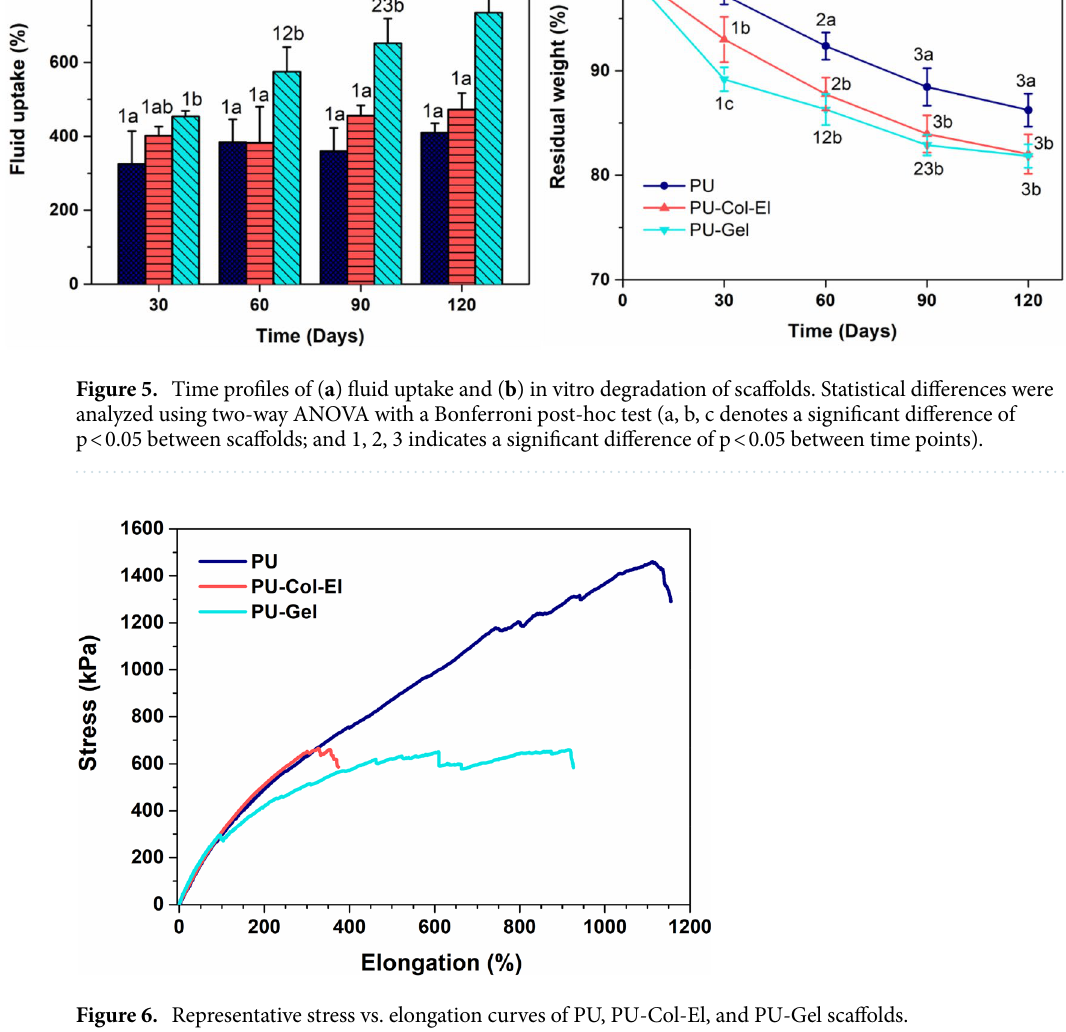
Figure 6. Representative stress vs. elongation curves of PU, PU-Col-El, and PU-Gel